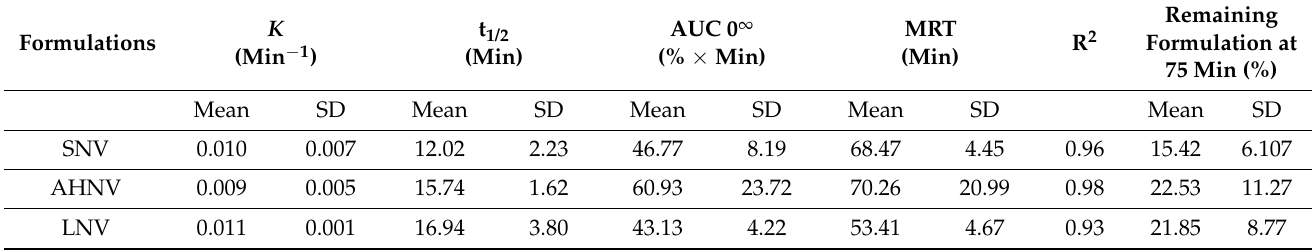
Figure 12. SNV, AHNV, and LNV clearance ratio from the ocular surface determination by PET. Ratio CT/C initial was calculated assuming C initial value obtained in the Regions of Interest (ROI). Table 8. Pharmacokinetic parameters ( K , t 1/2 , AUC 0 ∞ , and MRT) obtained by fitting the formulation percentage remaining in the eye over time by PET imaging.